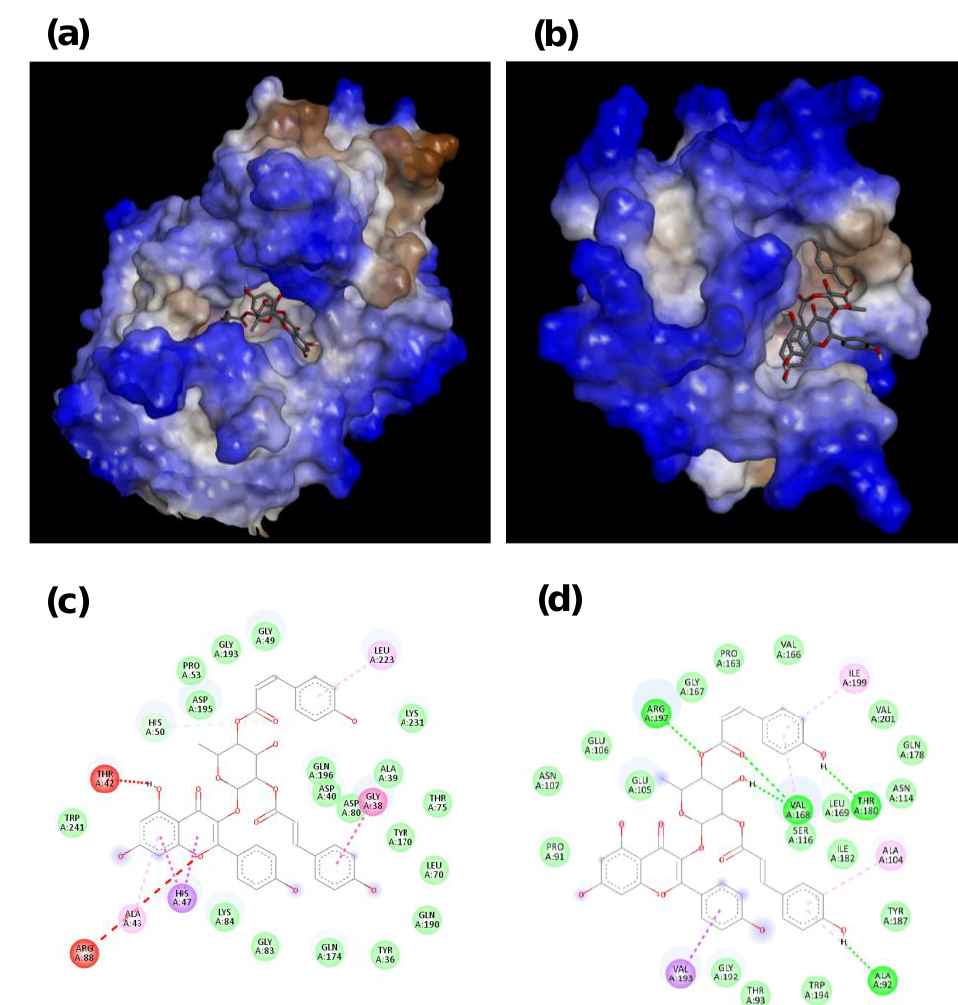
Figure 8. 3D orientation of kaempferol-3- O - α - L - (2″,4″ -di- E - p -coumaroyl)-rhamnopyranoside (com- pound 3 ) (shown in stick) at the active pocket of tyrosyl tRNA synthetase ( a ) and Sortase A ( b ); 2D representation of intermolecular interactions between the antimicrobial compound and enzyme targets tyrosyl tRNA synthetase ( c ) and Sortase A ( d ).